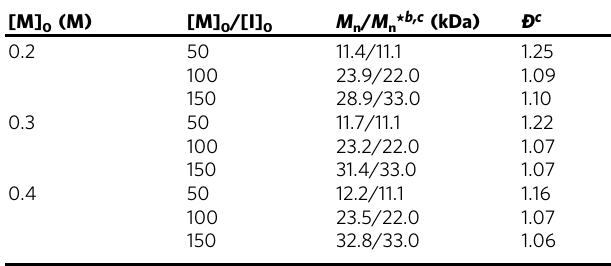
Table 1 Characterization of resulting polypeptides from linear polymerization of BLG-NCAs in DCM a